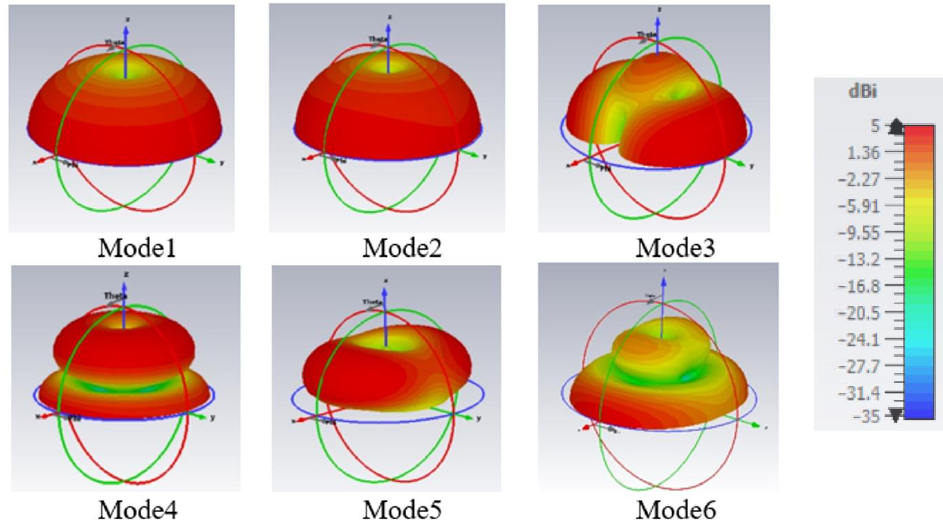
Figure 5. Modal radiation pattern (directivity) at resonance frequencies for Mode 1 at 0.79 GHz, Mode 2 at 1.85 GHz, Mode 3 at 2.01 GHz, Mode 4 at 3.05 GHz, Mode 5 at 3.17 GHz, and Mode 6 at 5.47 GHz.